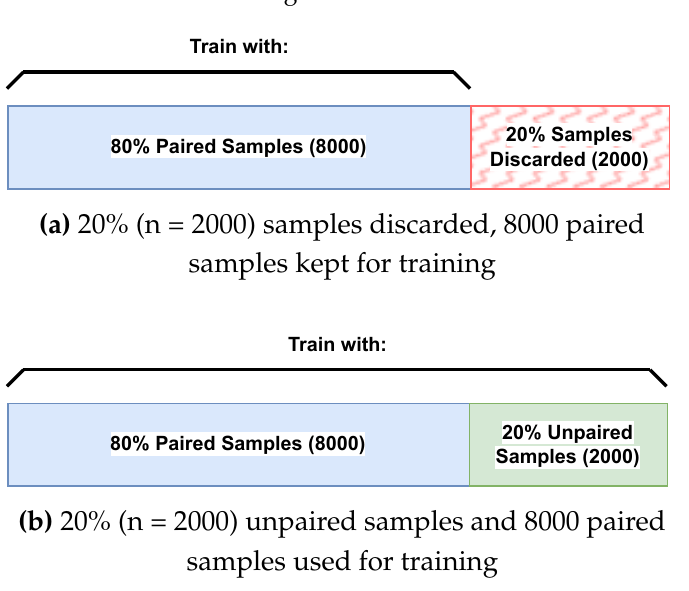
Figure 8. In ( a ), 20% of the training set was discarded. In ( b ), 20% of the training set was unpaired. In this example, for both ( a , b ), the model will be trained on 8000 paired samples. However, ( b ) will also train with its additional 2000 unpaired samples. This way, the effect of training with or without the additional unpaired samples can be investigated.